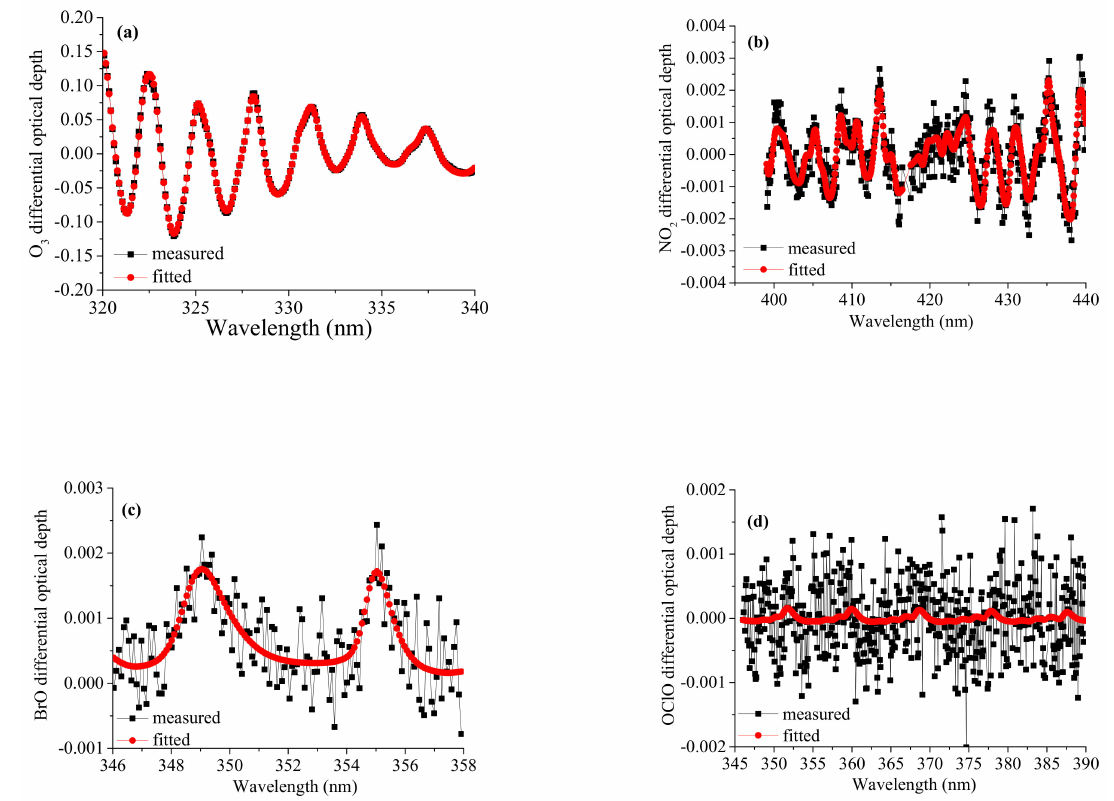
Figure 2. Examples of the spectral fits for ( a ) O 3 , ( b ) NO 2 , ( c ) BrO, and ( d ) OClO. Black and red symbols and lines indicate the measured and fitted spectral absorption structures, respectively. The derived O 3 , NO 2 , BrO, and OClO dSCDs are 2.87 × 10 19 molec · cm − 2 , 1.11 × 10 16 molec · cm − 2 , 2.10 × 10 14 molec · cm − 2 , and 2.00 × 10 13 molec · cm − 2 , respectively. The root mean squares (RMSs) of the fit residuals between the measured and fitted spectra are 2.34 × 10 − 3 , 5.28 × 10 − 4 , 4.47 × 10 − 4 , and 5.60 × 10 − 4 ,